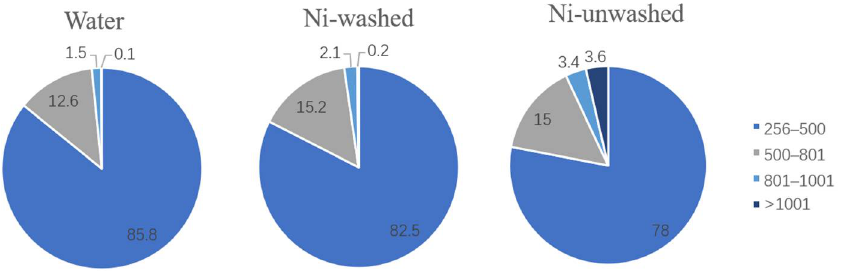
Figure 5. The molecular weight distribution of compounds in